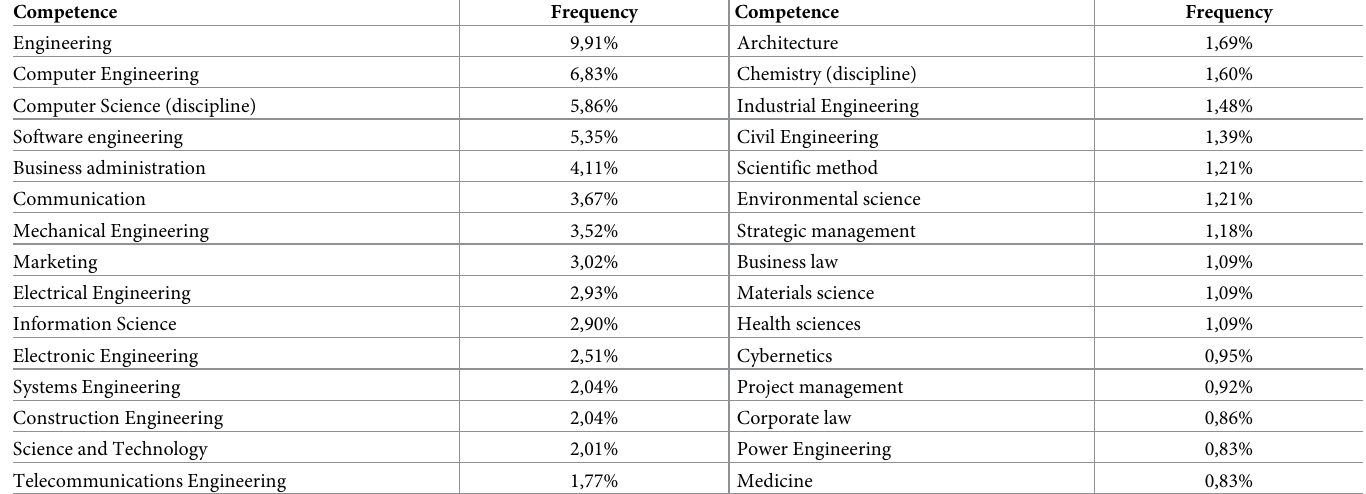
Table 4. Top 30 competencies and relative